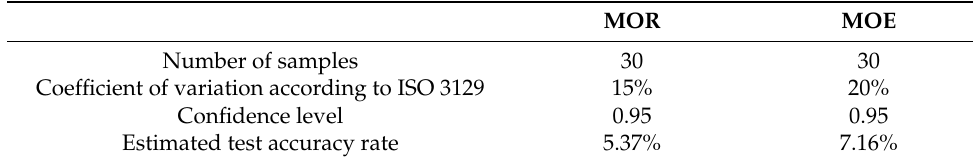
Table 5. Estimation of the test accuracy rates.